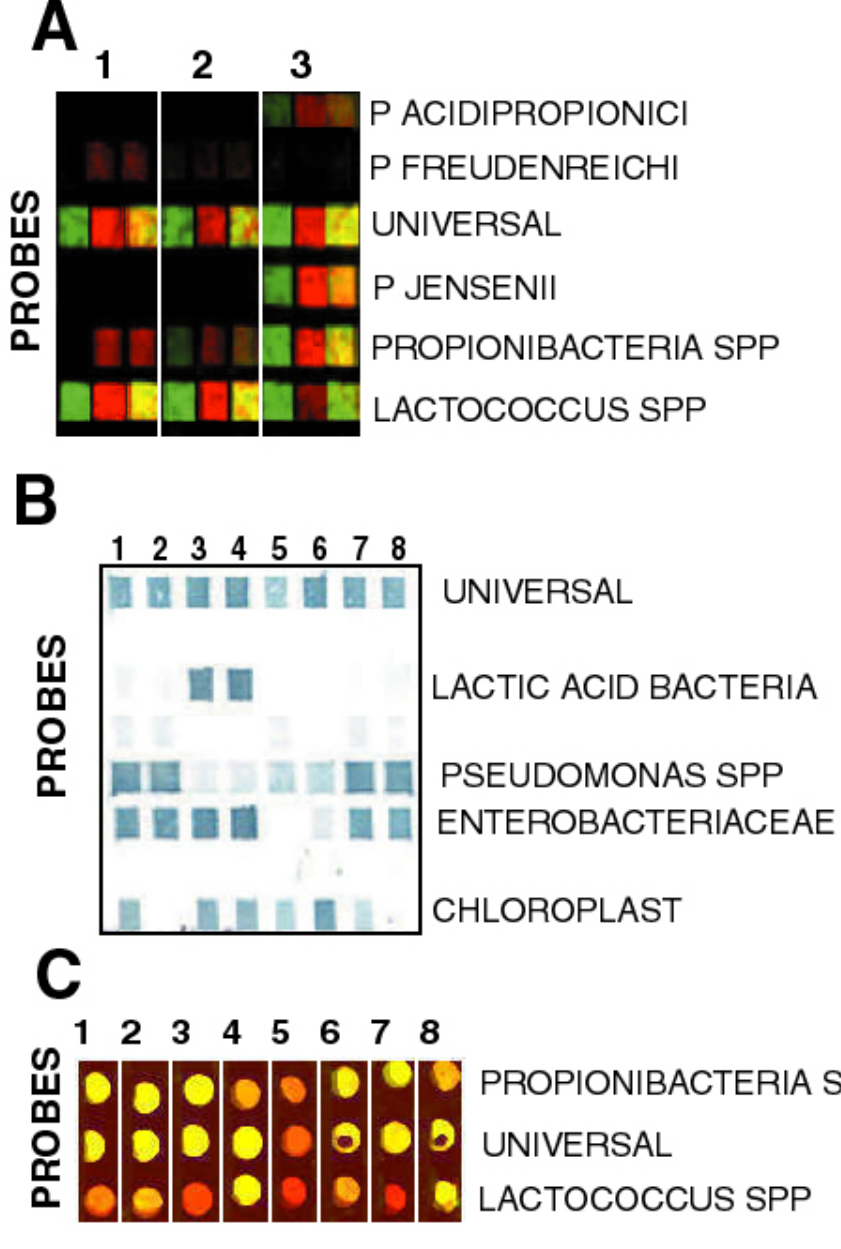
FIGURE 3. Examples of detection formats. (A) Direct fluorescence membrane-based detection; the fluorescence from a 24-h sample (green) was compared to that of a sample after 48 h incubation (red). The last column shows an overlay of the two colors. The signals were obtained using a Typhoon model 8600 scanner (Amersham Pharmacia). The following samples were tested: 1 and 2 — different mixtures of Lactococcus lactis subsp. L2 and Propionibacteria freudenreichi P59; 3 — mixture of Lactococcus lactis subsp. L2, Propionibacteria freudenreichi P59, Propionibacteria acidipropionici ATCC 4965 and Propionibacteria jensenii 9614. (B) Chromogenic membrane-based detection; the intensity of the blue color represents the relative amount of a given target. The samples represent the communities identified in eight different salad batches. (C) Glass slide multicolor detection. The direct fluorescence from the sequence-specific labeling (green) is determined relative to an internal control probe (red). The samples 1–8 show different mixtures of Lactococcus lactis subsp. L2 and Propionibacteria freudenreichi